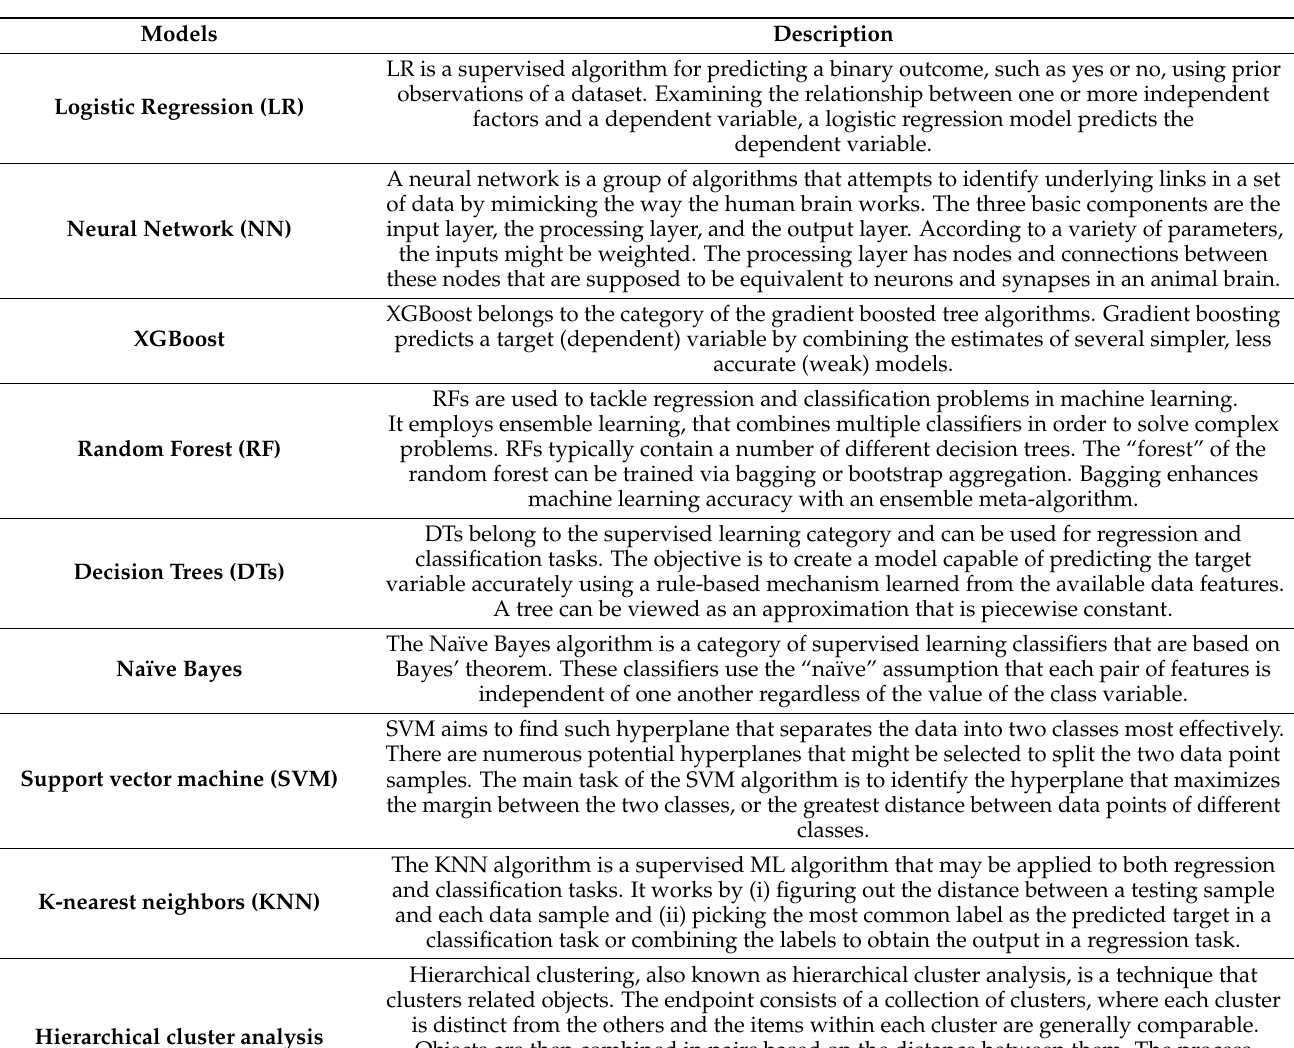
Table 1. A brief summary of the ML models presented in the papers in our